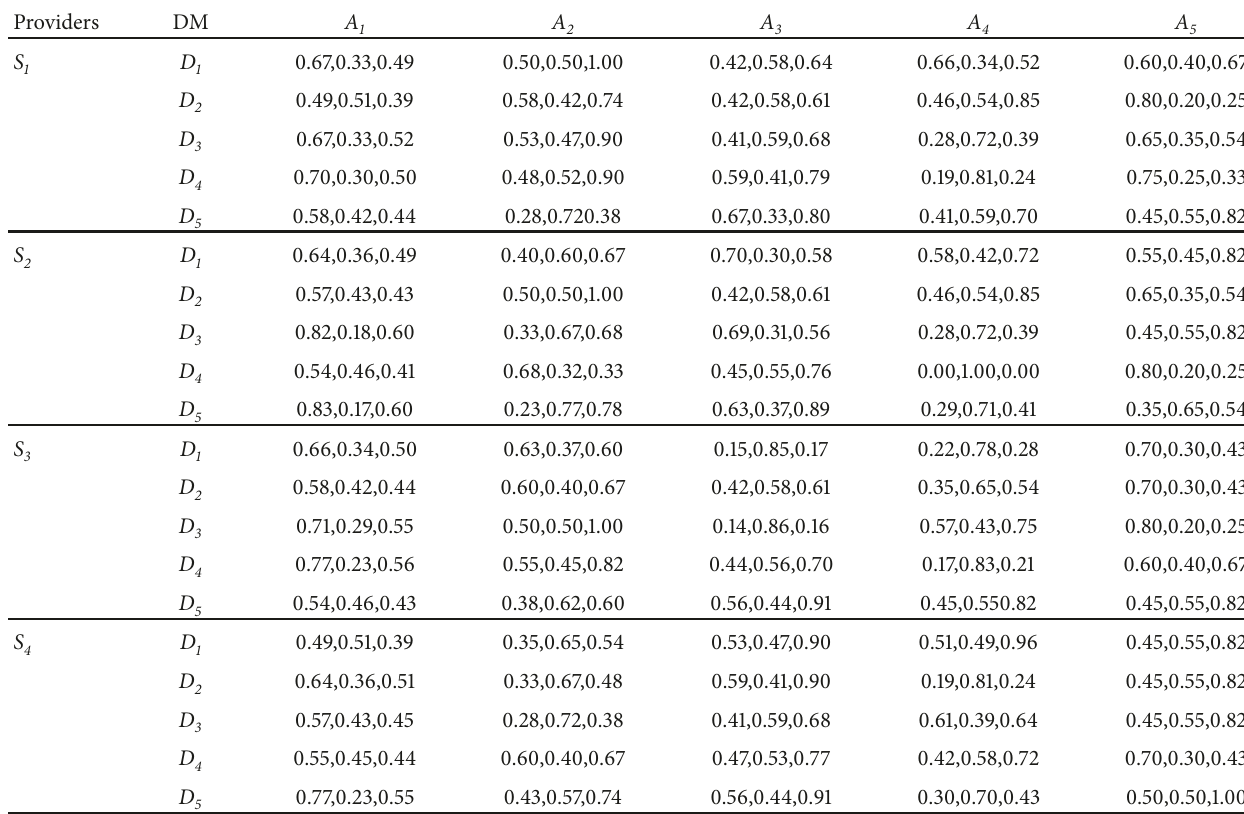
Table 2: Rsd, Rdd and Rud of each attribute